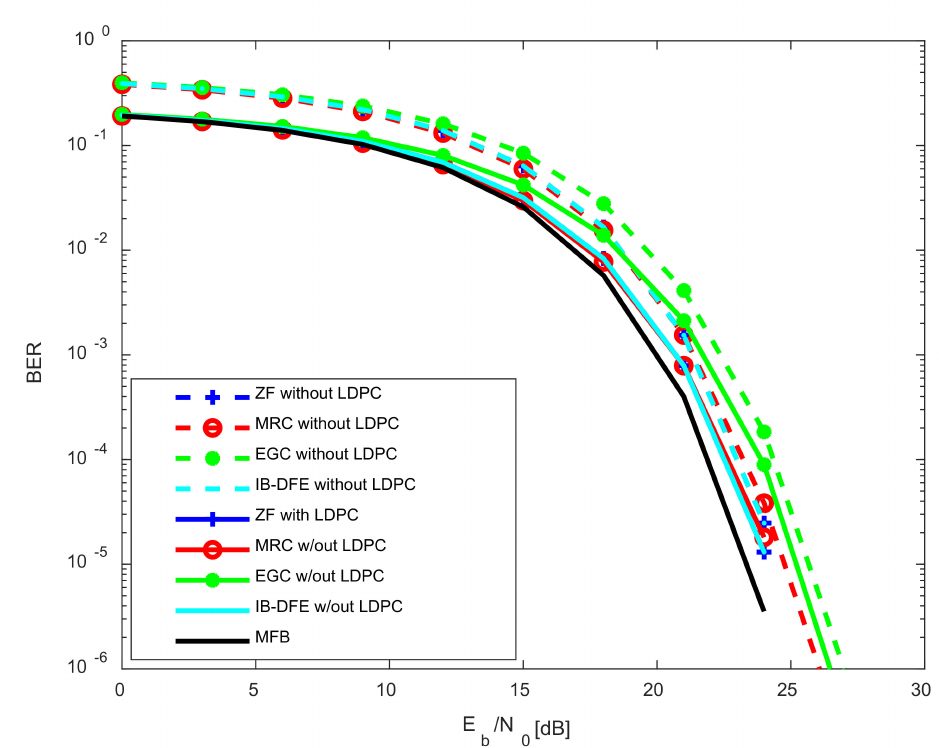
Figure 4. Results for 4 × 32 MIMO, with and without LDPC codes, with impulsive noise, with ideal channel estimation and without channel correlation between antennas.